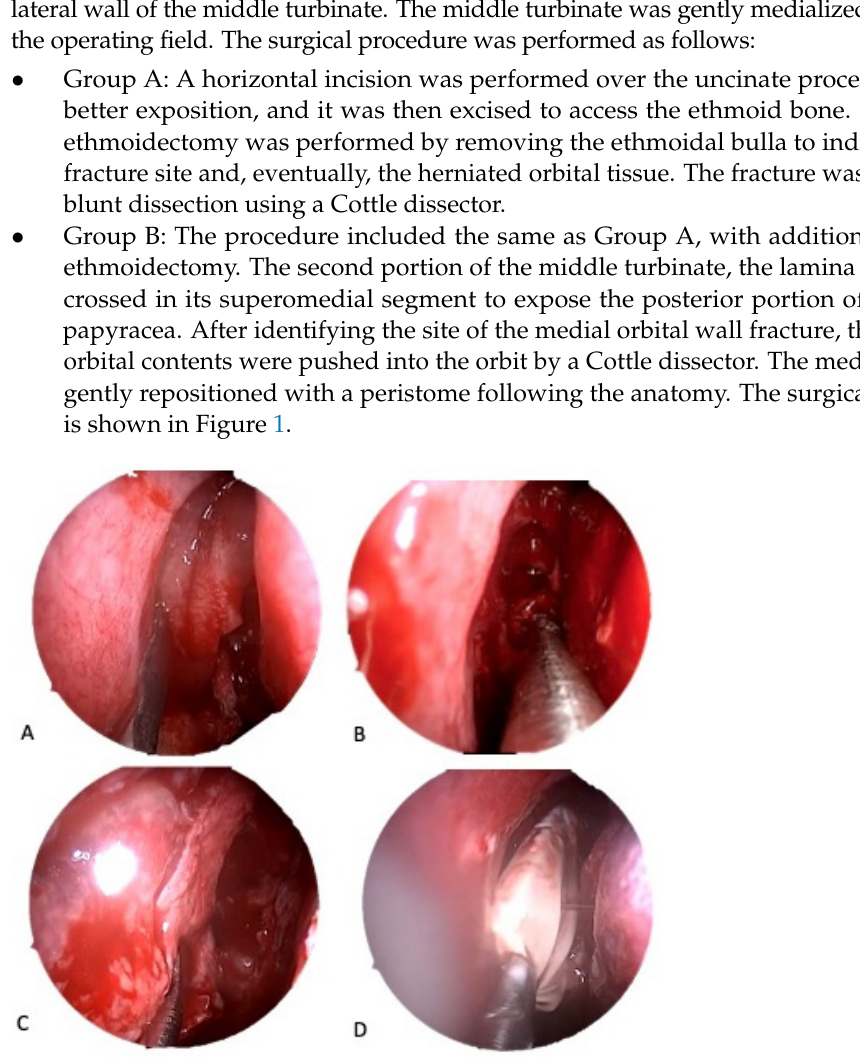
Figure 1. Surgical Procedure: ( A ) uncinectomy; ( B ) bullectomy; ( C ) fracture reduction; ( D ) splint positioning.